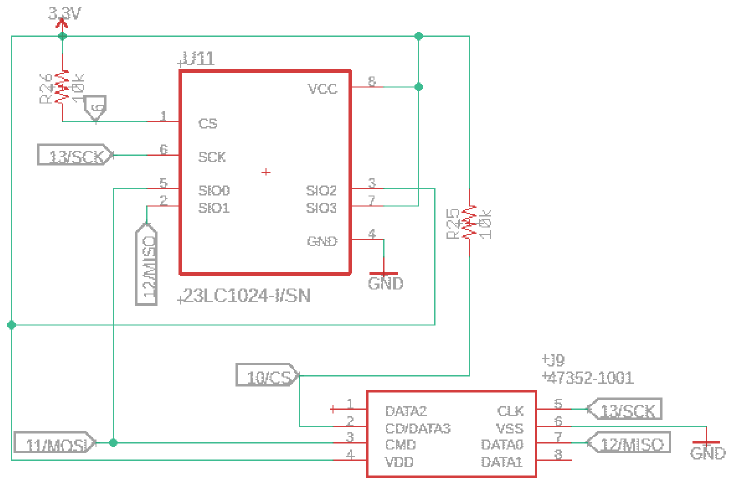
Figure 6. Audio RAM chip memory